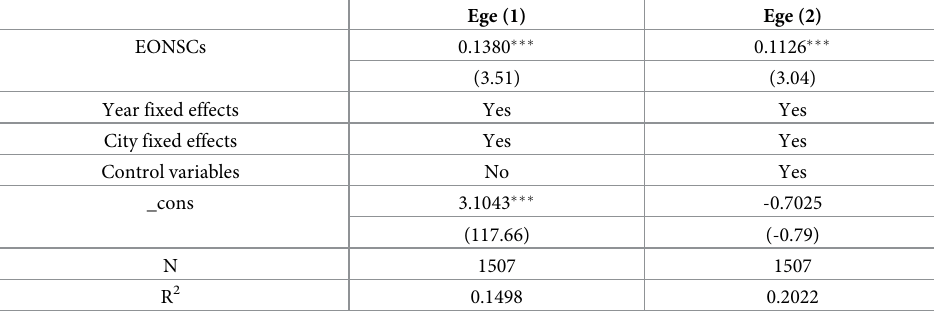
Note: t-statistics in parentheses; ��� represents the 1% significance level.